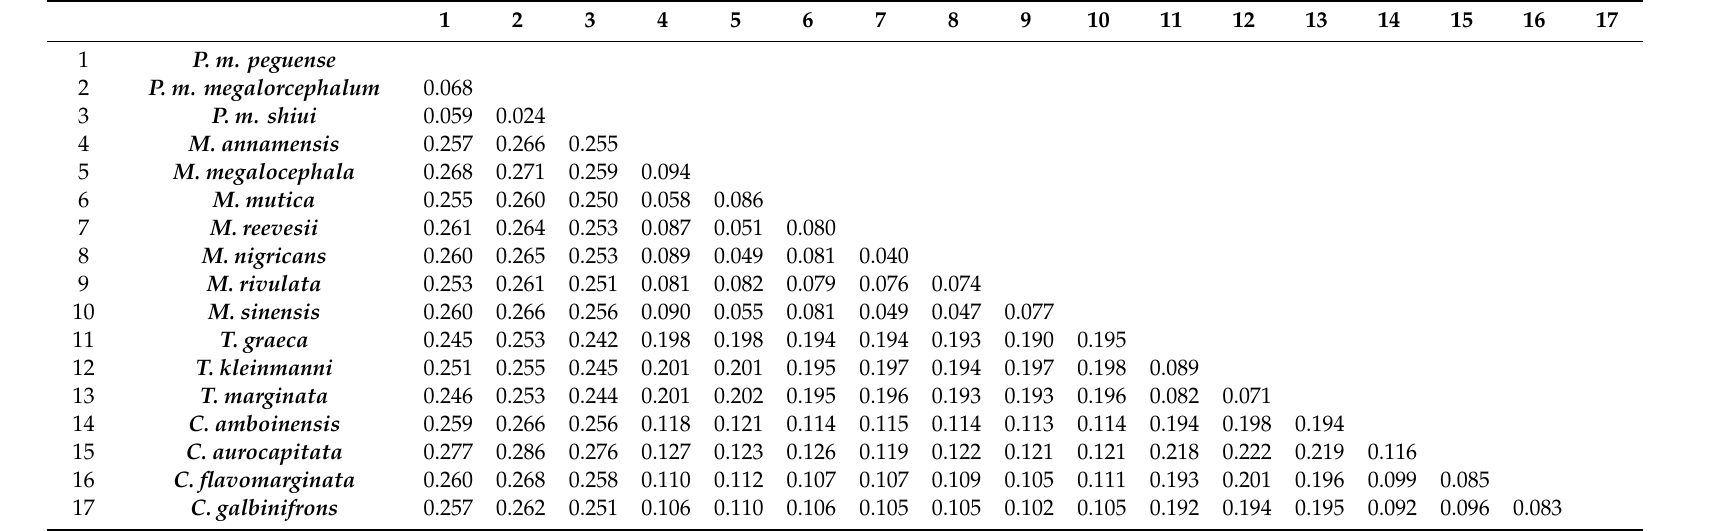
Table 3. Genetic distances based on 13 PCGs of turtles from 17 species of four